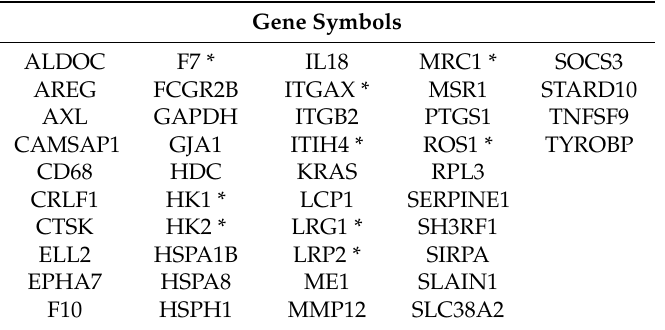
Table 3. List of genes with increased intronic RNA expression after Vitamin E supplement treatment that overlapped with the genes in the oncogenic KRAS2 expression signature. The gene symbols with asterisk also had increased expression of introns after NAC supplement treatment.